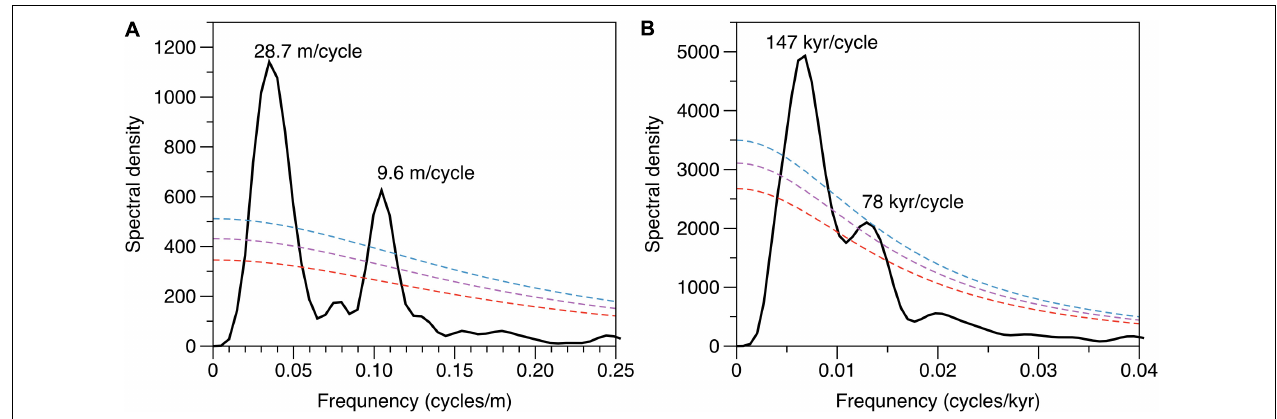
FIGURE 3 | Spectral analyses of the clay fraction from core NHH01 in depth (A) and time (B) domain against the initial age model constrained by paleomagnetic results, with their 80% (red), 90% (purple), and 95% (blue) significance levels indicated with dashed lines.